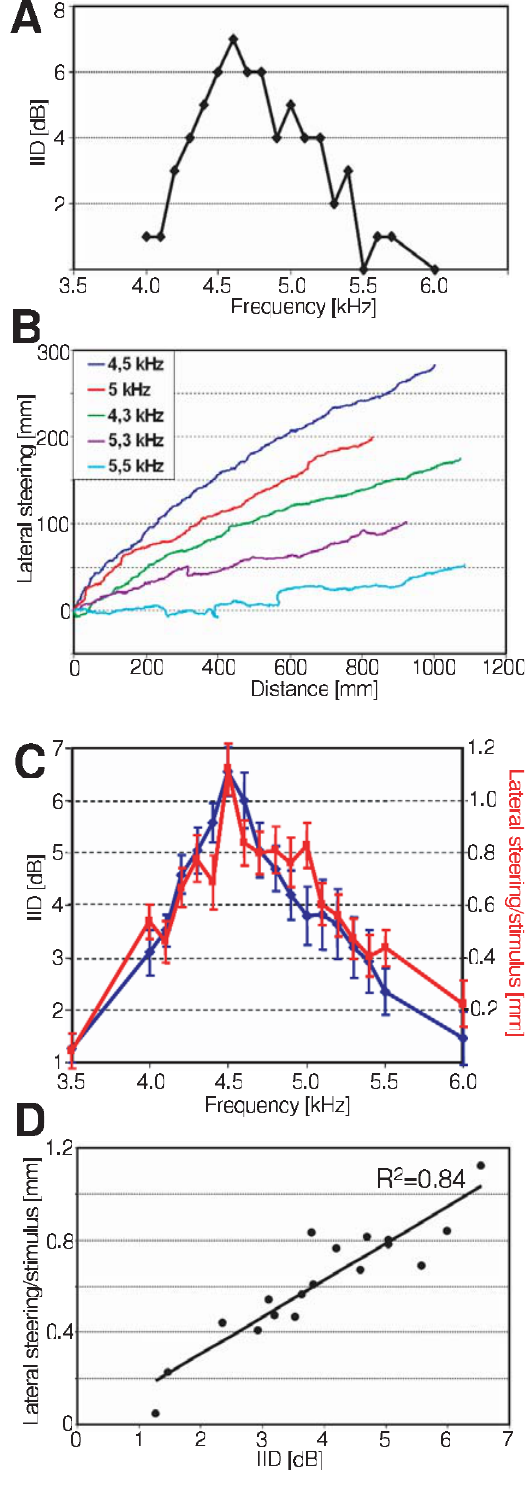
Figure 3. Interaural intensity differences exhibit optimum functions and determine the degree of lateral steering in no- choice paradigms. In a single female, the amount of IID provided by the peripheral directionality (A) correlates with the degree of steering (B). (C) On average, the peripheral directionality is tuned to 4.5 kHz, i.e. provides the highest IIDs (blue; mean 6 SE; N=20), although optima in single females vary from 4.0 to 5.1 kHz. The lateral steering in no-choice